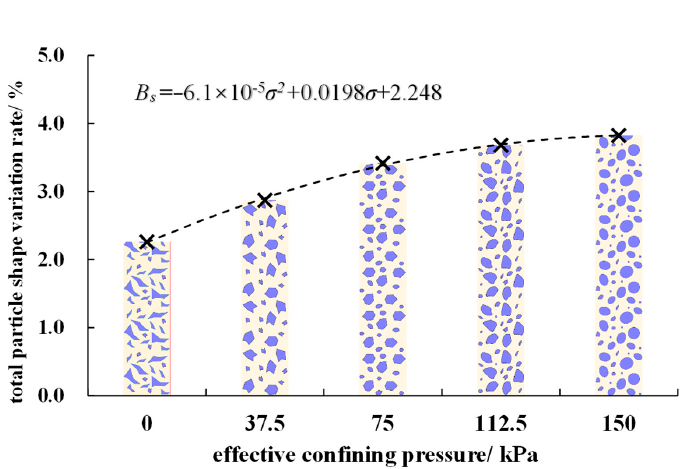
Figure 15. The effect of effective confining pressure on the total particle shape of silt.